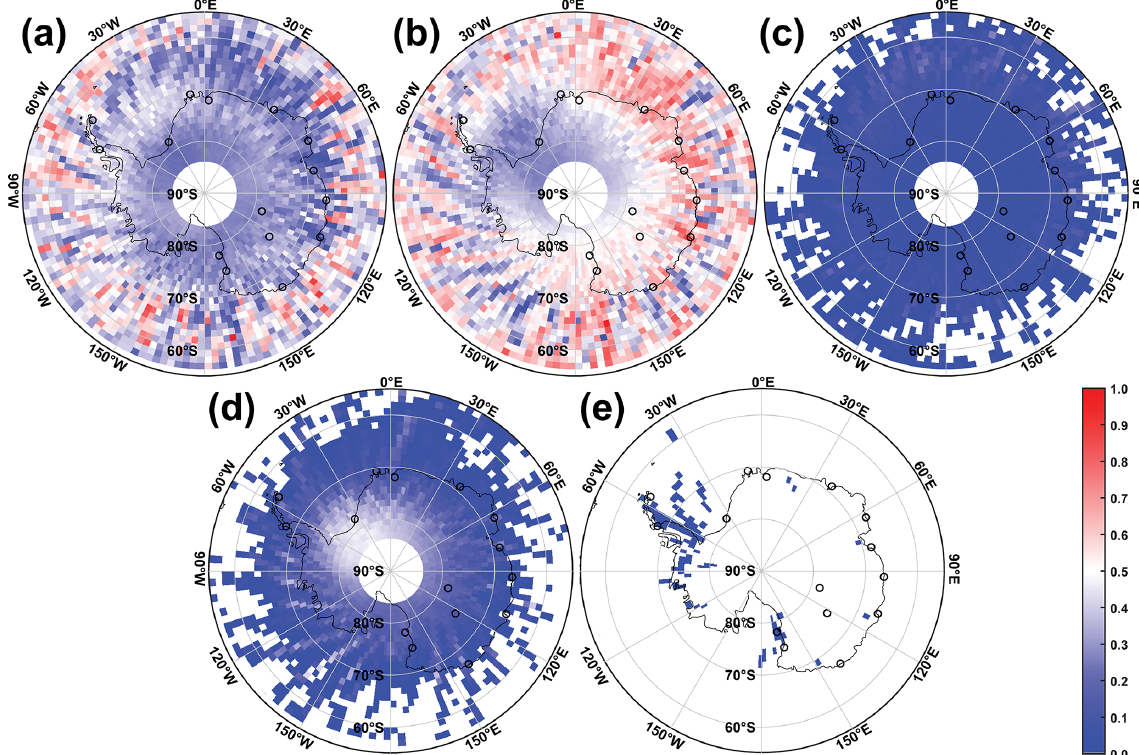
Figure 6. Same as Fig. 3 but for the Antarctic.